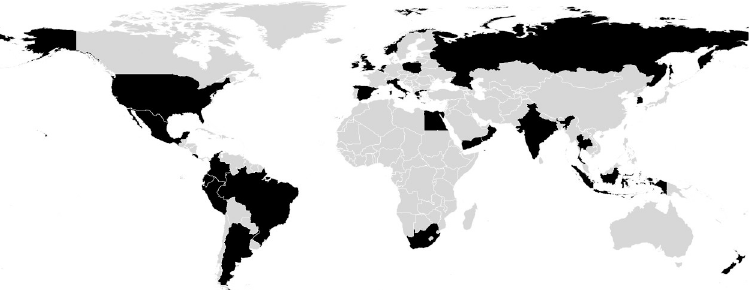
Fig 1. Map illustrating countries from which CZI/CABANA workshop participants attended (map base layer was plotted with data obtained from Natural Earth, https://www.naturalearthdata.com/). CZI, Chan Zuckerberg